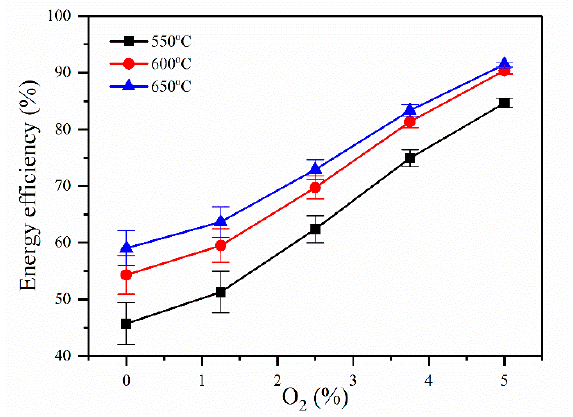
Figure 6. Effect of temperature and oxygen concentration on energy efficiency. Figure 6. E ff ect of temperature and oxygen concentration on energy e ffi